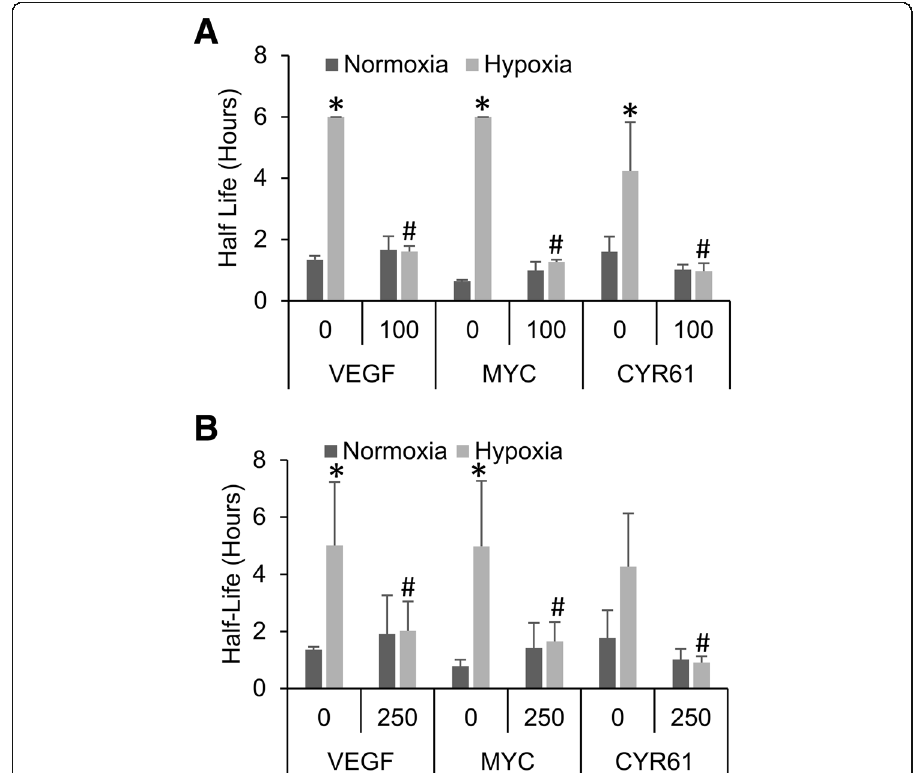
Fig. 3 Hypoxic mRNA stability requires functional mitochondria. HEK293T cells pre-treated with mitochondrial inhibitors rotenone ( a ) or myxothiazol ( b ), and then exposed to 24 h of Normoxia or Hypoxia (1% O 2 ) in the presence of 1 g/L glucose before being treated with actinomycin D for 0, 1 or 2 h. mRNA levels of VEGF, MYC and CYR61 were determined via qPCR, normalized to GAPDH and 0 h time point and half-lives determined. Data represents average of N ≥ 3 ± SD for each condition. * P ≤ 0.05 from